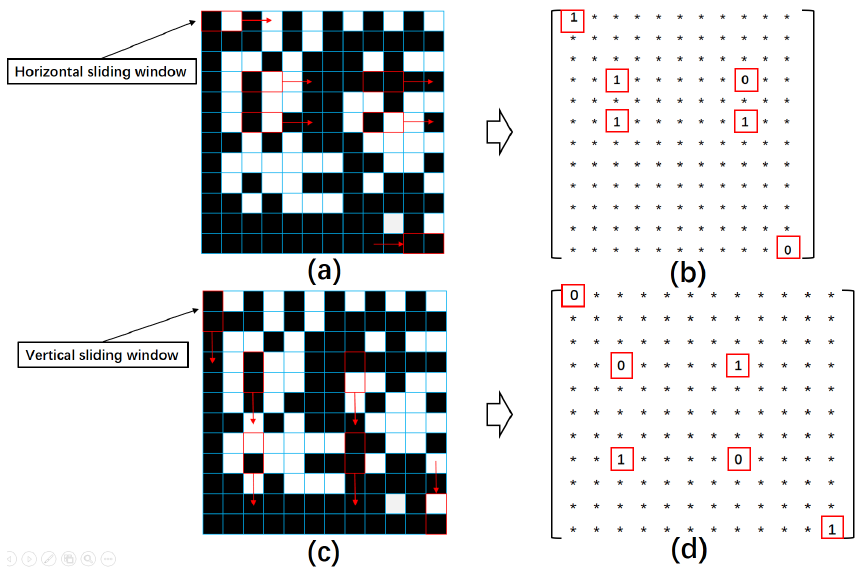
Figure 7. Demonstration of the inputs and outputs of the CNN model for a 12 × 12 DM barcode. ( a , c ) The horizontal and vertical sliding window sampling in the grid format of the barcode image, respectively; ( b , d ) the label matrix for the horizontal and vertical pairs,